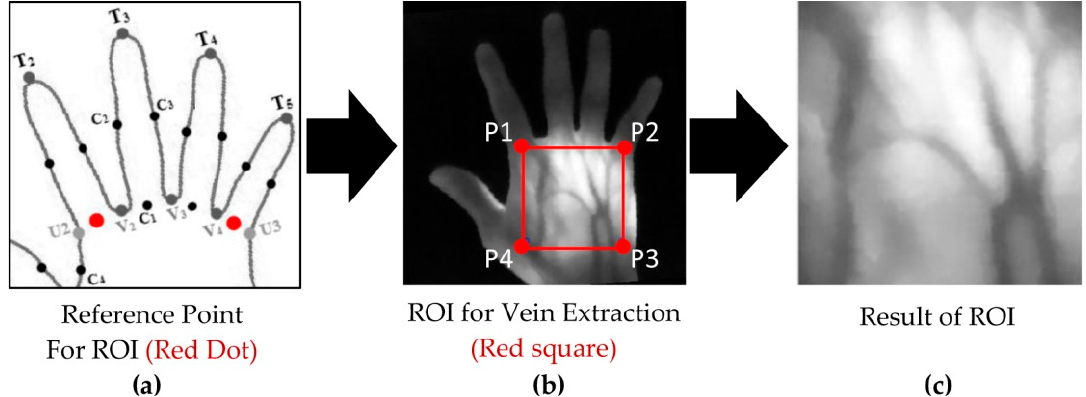
Figure 8. Vein pattern ROI extraction: ( a ) reference point for ROI; ( b ) ROI for vein extraction; and ( c ) result of ROI.